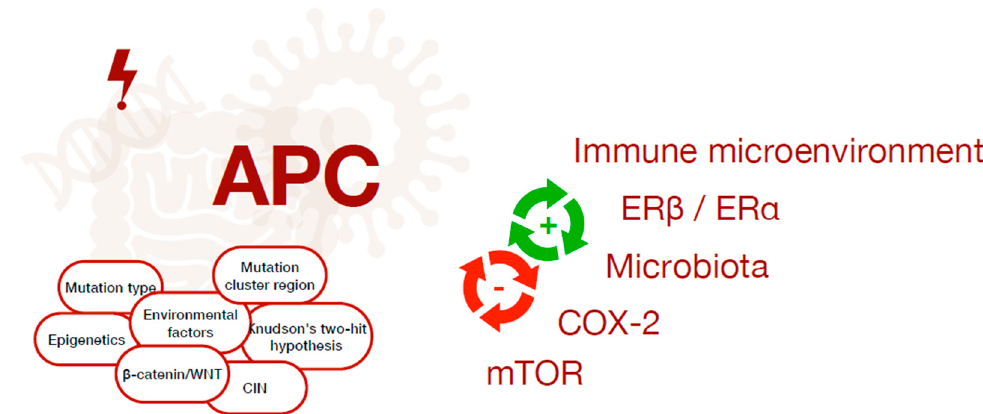
Figure 2. The complex interplay between several factors contributing to cancer onset in FAP pa- tients, which depend on the interaction between genetic, environmental, hormonal, microbial and immunological factors.